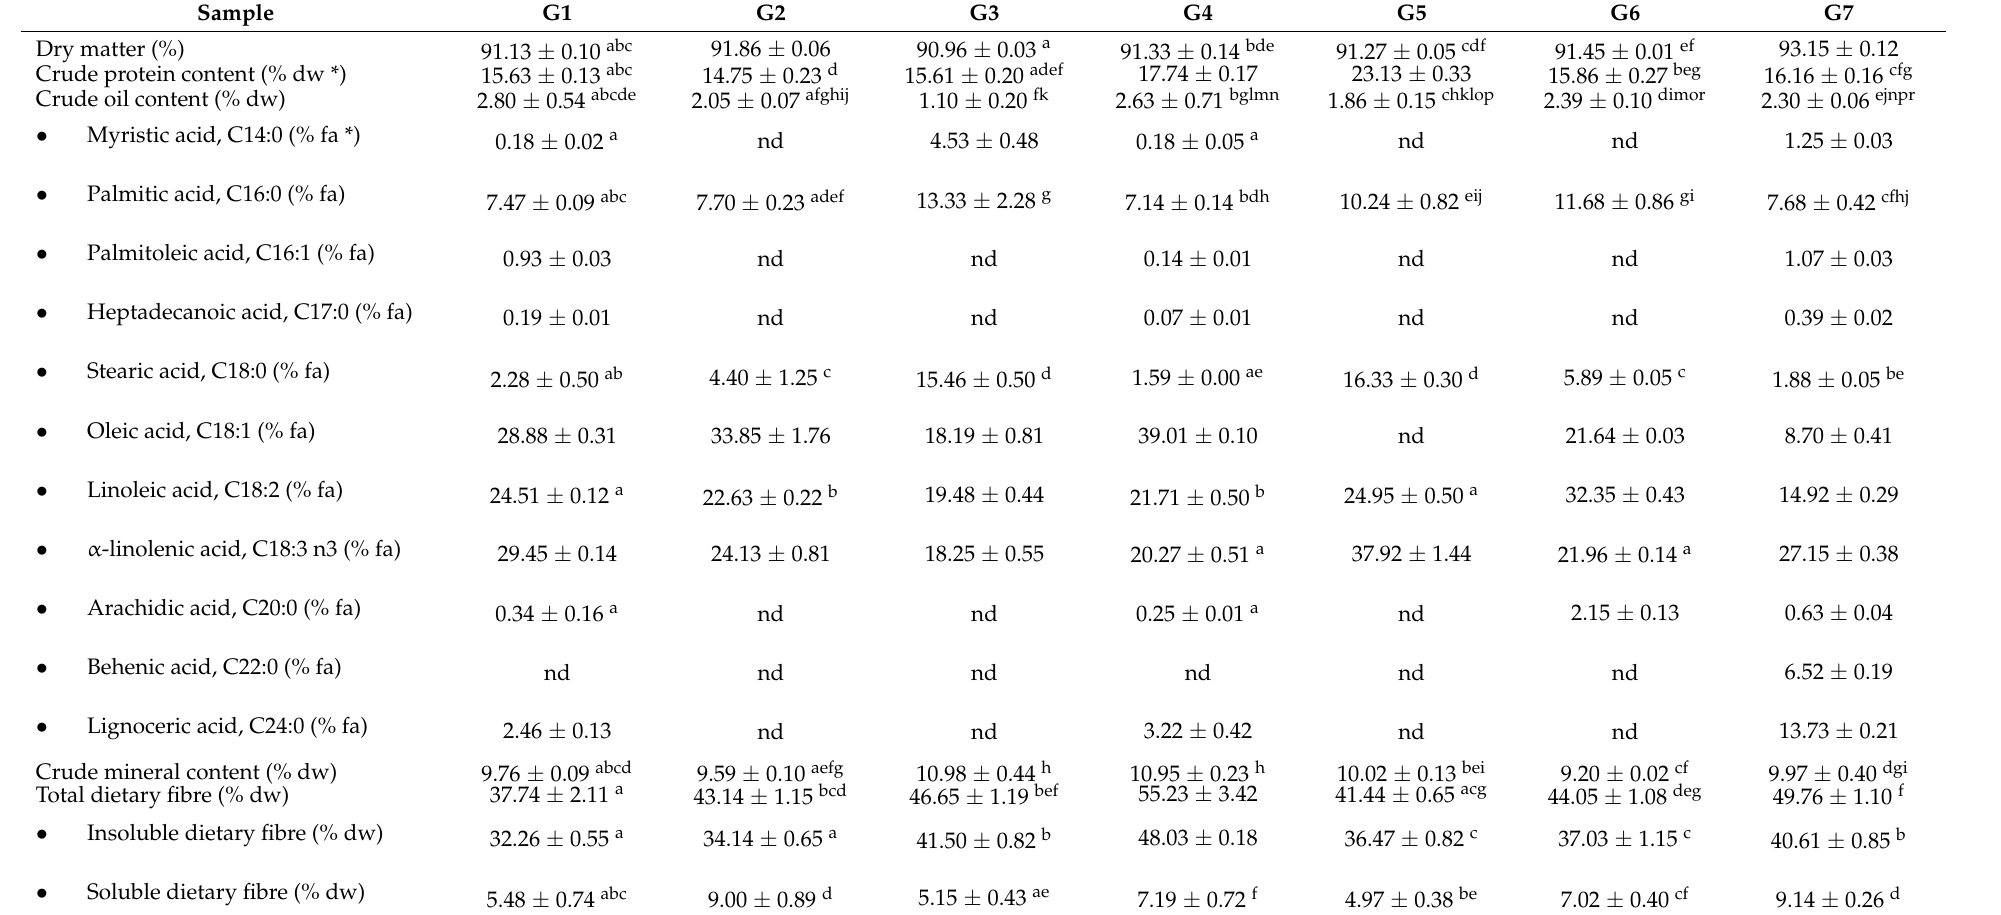
Table 1. Nutritional composition of ground ivy harvested from different natural